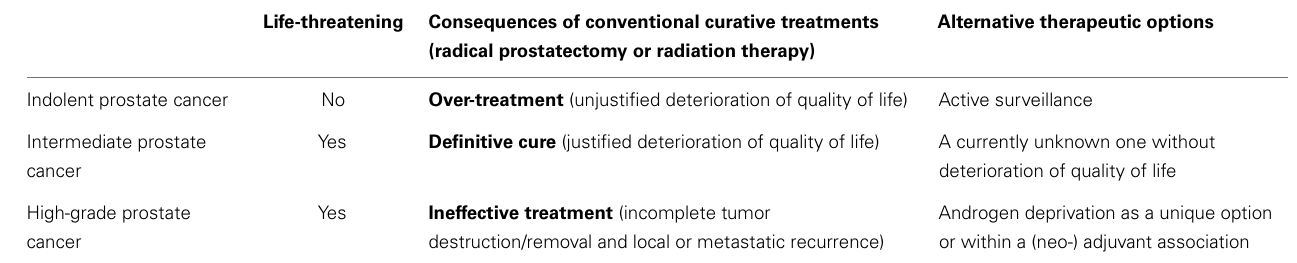
Table 1 |The therapeutic stakes of prostate cancer